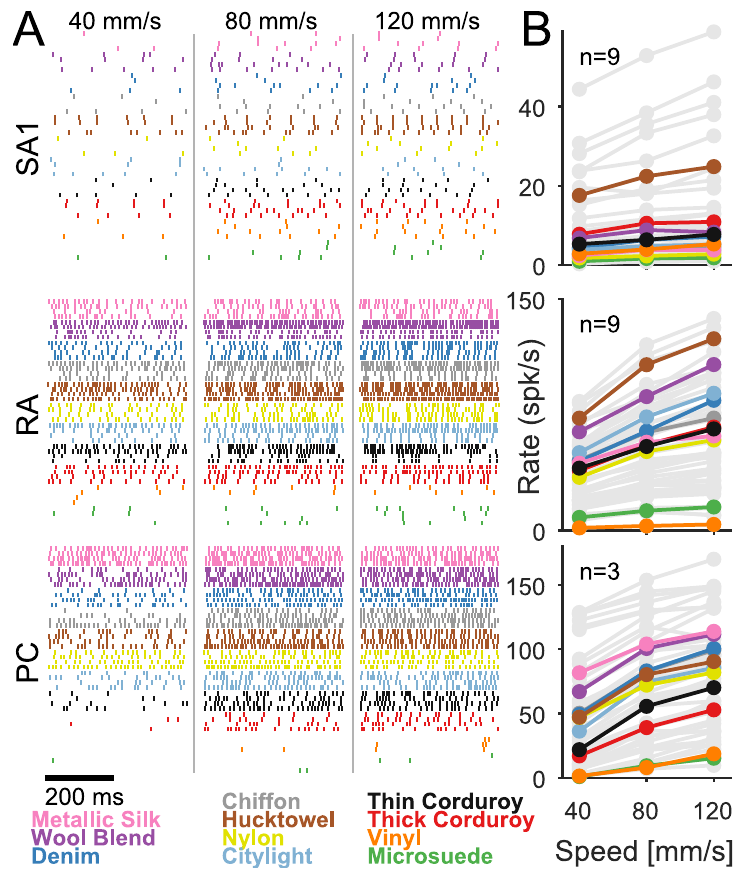
Fig 4. Speed dependence of the responses of tactile nerve fibers. (A) Spiking responses of two nerve fibers from each class (SA1, RA, and PC fibers) to two repeated presentations of 11 different textures scanned at three different speeds. (B) Mean firing rate across fibers of each type. Each color is a different texture (see legend at the bottom left); light gray represents the textures not used in the psychophysical experiments. Data underlying this figure can be found in S1 Data. PC, Pacinian corpuscle–associated; RA, rapidly adapting; SA1, slowly adapting type 1.